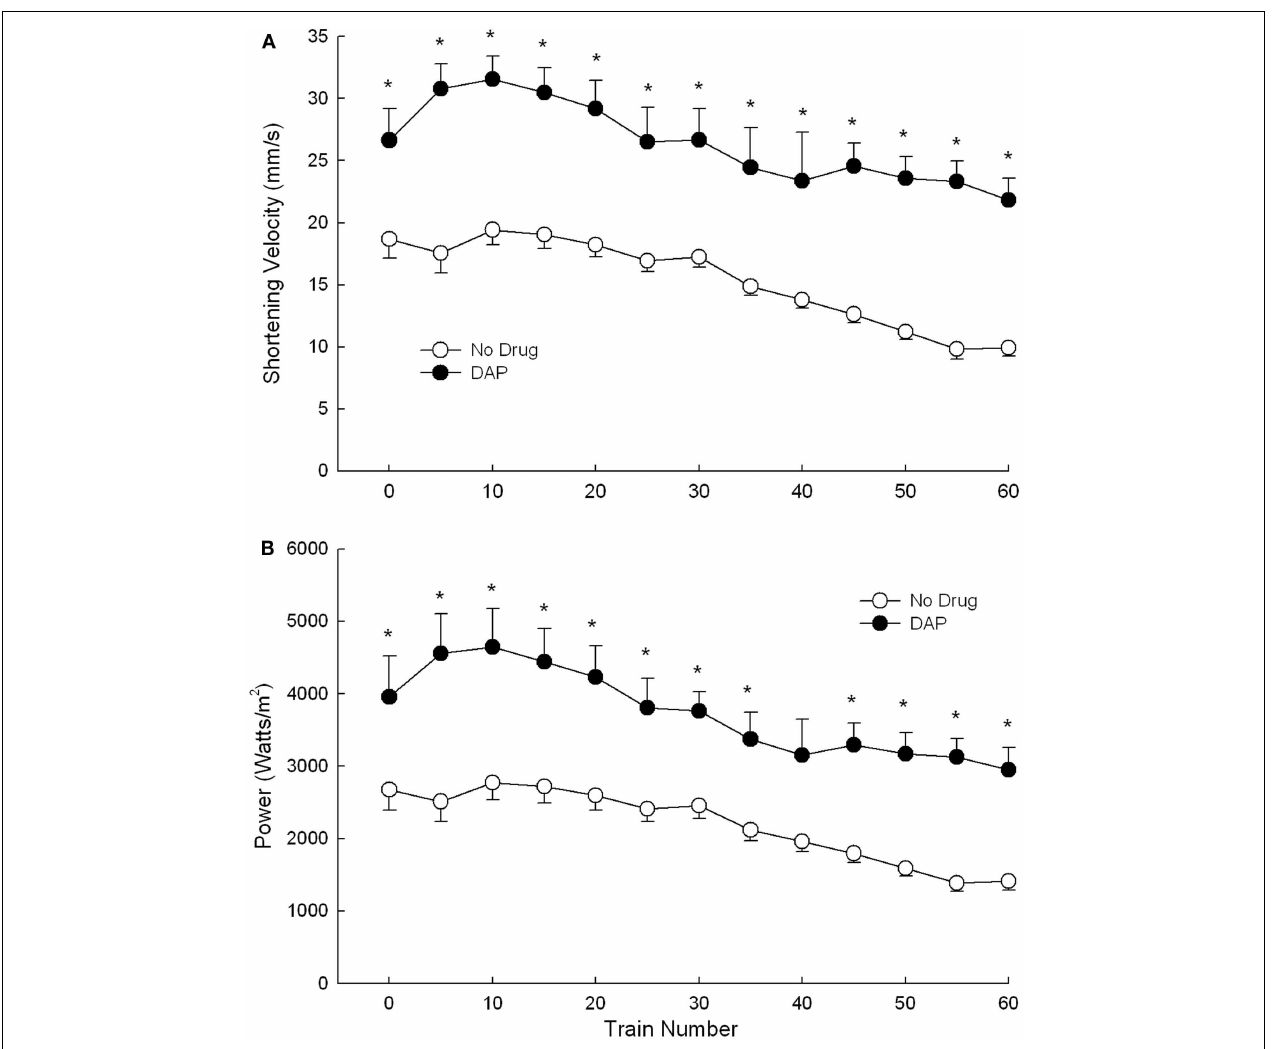
FIGURE 5 | Effects of DAP on shortening velocity (A) and power (B) during 40Hz isotonic contraction at 40% load over the first 60 trains. Values are means ±